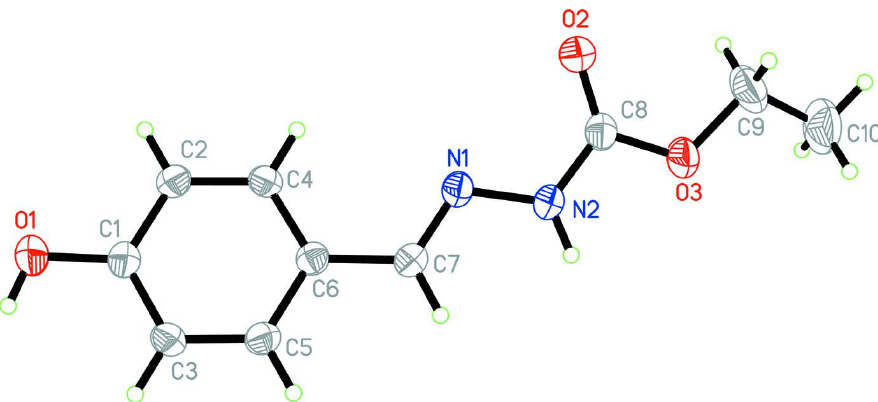
Figure 1 Molecular structure of the title compound, showing 30% probability displacement ellipsoids and the atomic numbering.